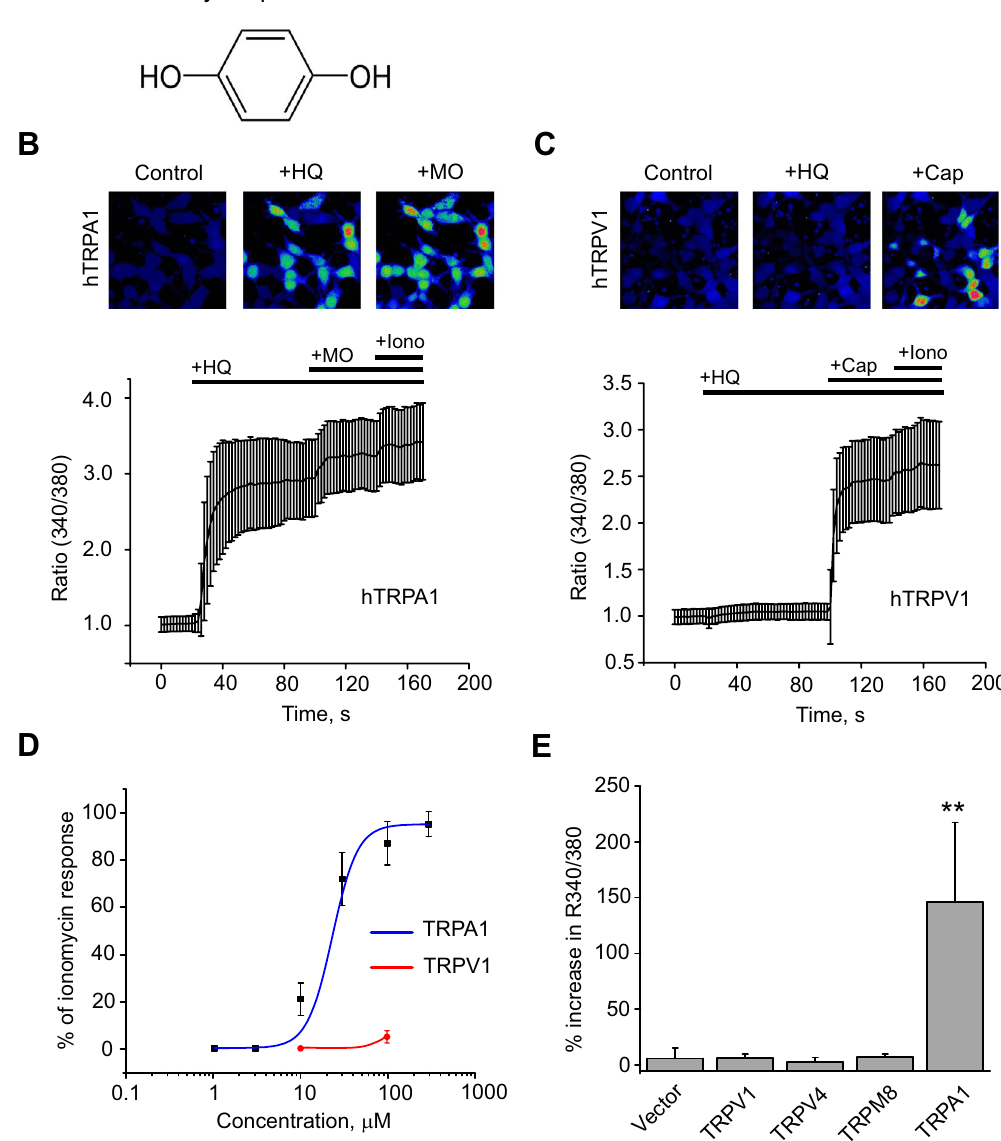
Figure 1. HQ selectively and dose-dependently actives TRPA1 channel heterologously expressed in HEK 293 cells. ( A ) Molecular structure of HQ. ( B ) Top: Representative pseudo color images from Fura-2-loaded HEK 293 cells expressing human TRPA1, displaying intracellular Ca 2 + resonses. Cells are shown in resting state (left), followed by response to HQ (HQ, 100 µ M, middle) and to mustard oil (MO, 70 µ M, right), used as positive control to stimulate TRPA1. Bottom: Average Ca 2 + responses plotted against stimulus. As final stimulus ionomycin (1.5 µ M) was used to stimulate all live cells. ( C ) Examination of responsiveness of human TRPV1 to HQ (HQ, 100 µ M) and capsaicin (Cap, 300 nM), as positive control. ( D ) Dose-response analysis showing the effects of different concentrations of HQ on TRPA1 and TRPV1 expressed in HEK 293 cells. The response to HQ was normalized to that to ionomycin (1.5 µ M). ( E ) Effects of HQ (30 µ M) on hTRPA1 compared to effects on human TRPV1, TRPV4, TRPM8 and empty vector (pcDNA3.1) in Ca 2 + imaging tests. n = 20–40 cells/ group. ** p < 0.01 vs . vector